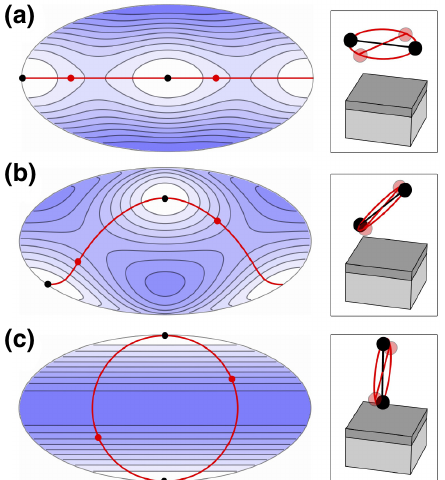
FIG. 3. Rotational decoherence rate of a two-ion Coulomb crystal [25] rotating around a fixed center-of-mass position near a dielectric layer deposited on bulk gold. (a) The contour plot in Mollweide projection displays the rate (18) for a superposi- tion between two orientations with one parallel to the surface (black dumbbell and dots). The plot is normalized to the max- imum decoherence rate of (cid:13) max = 3.7 kHz (blue). Great-circle trajectories of the second branch are shown in red. In panels (b) and (c) the fixed orientation (black dumbbell) is set to 45 ◦ and 90 ◦ to the surface plane,